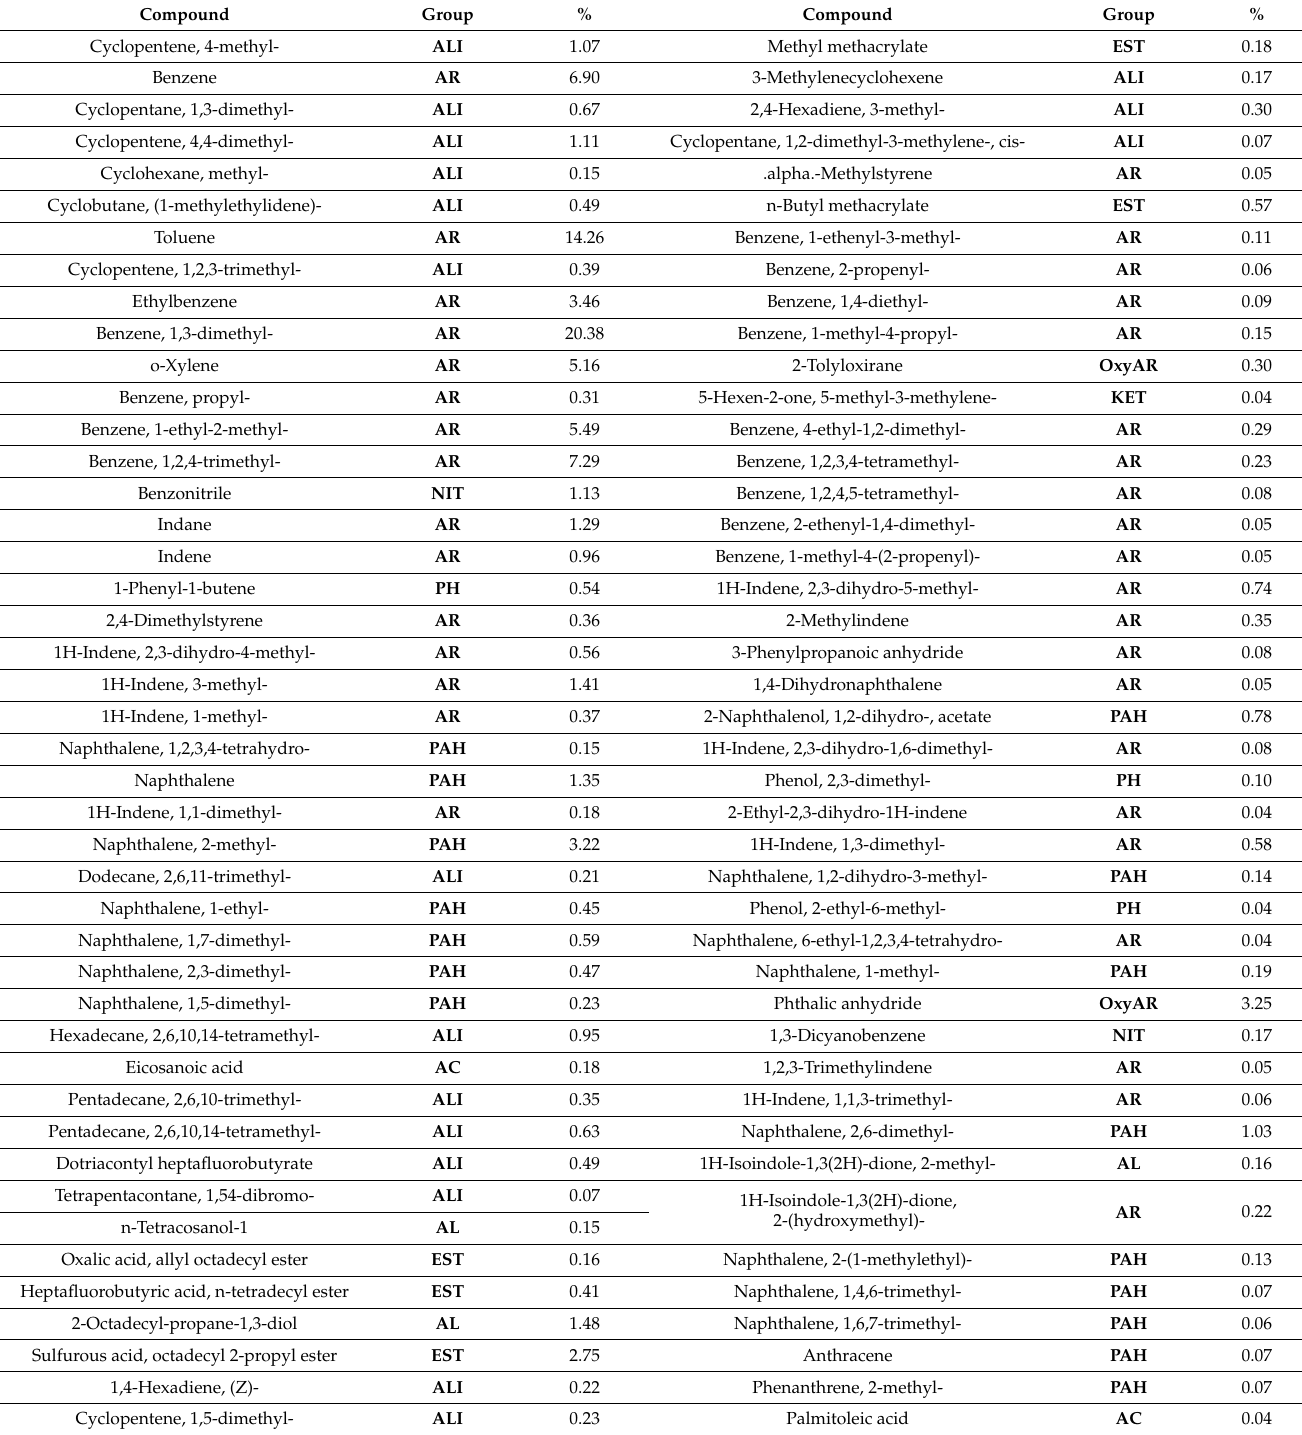
Table 3. Composition of bio-oil derived from catalytic fast pyrolysis (with ZSM-5 zeolite as catalysts) of residual paint (NAS-2) in the Py/GC-MS system, at 600 ◦ C (GC-MS peak area,